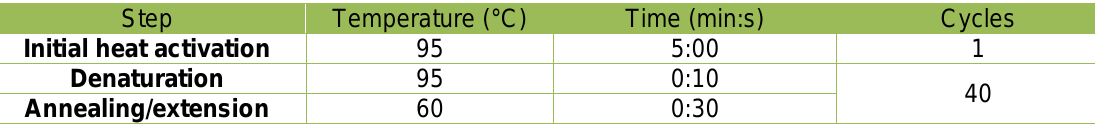
Table 4: Thermocycling profile for qPCR